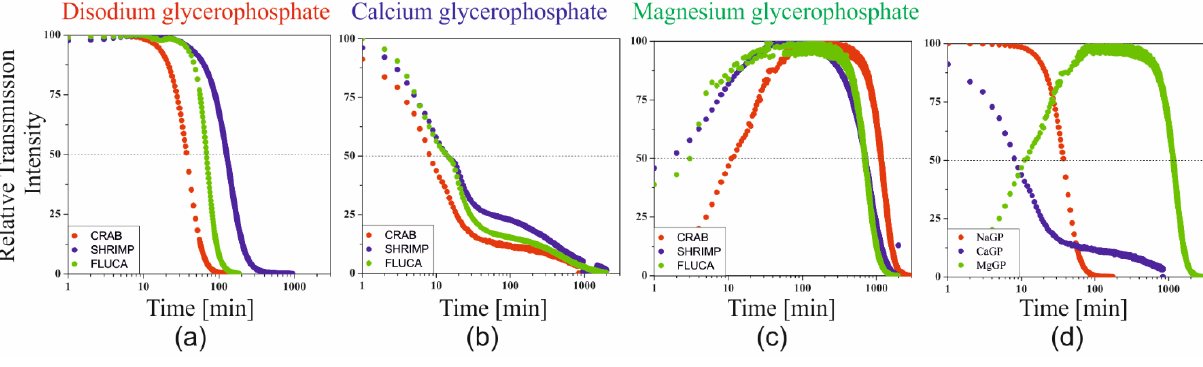
Figure 6. Changes in the relative intensity of transmittance for chitosan systems containing ( a ) sodium, ( b ) calcium, and ( c ) magnesium glycerophosphate. ( d ) Comparison of the relative transmission for the system obtained from crab-derived chitosan.